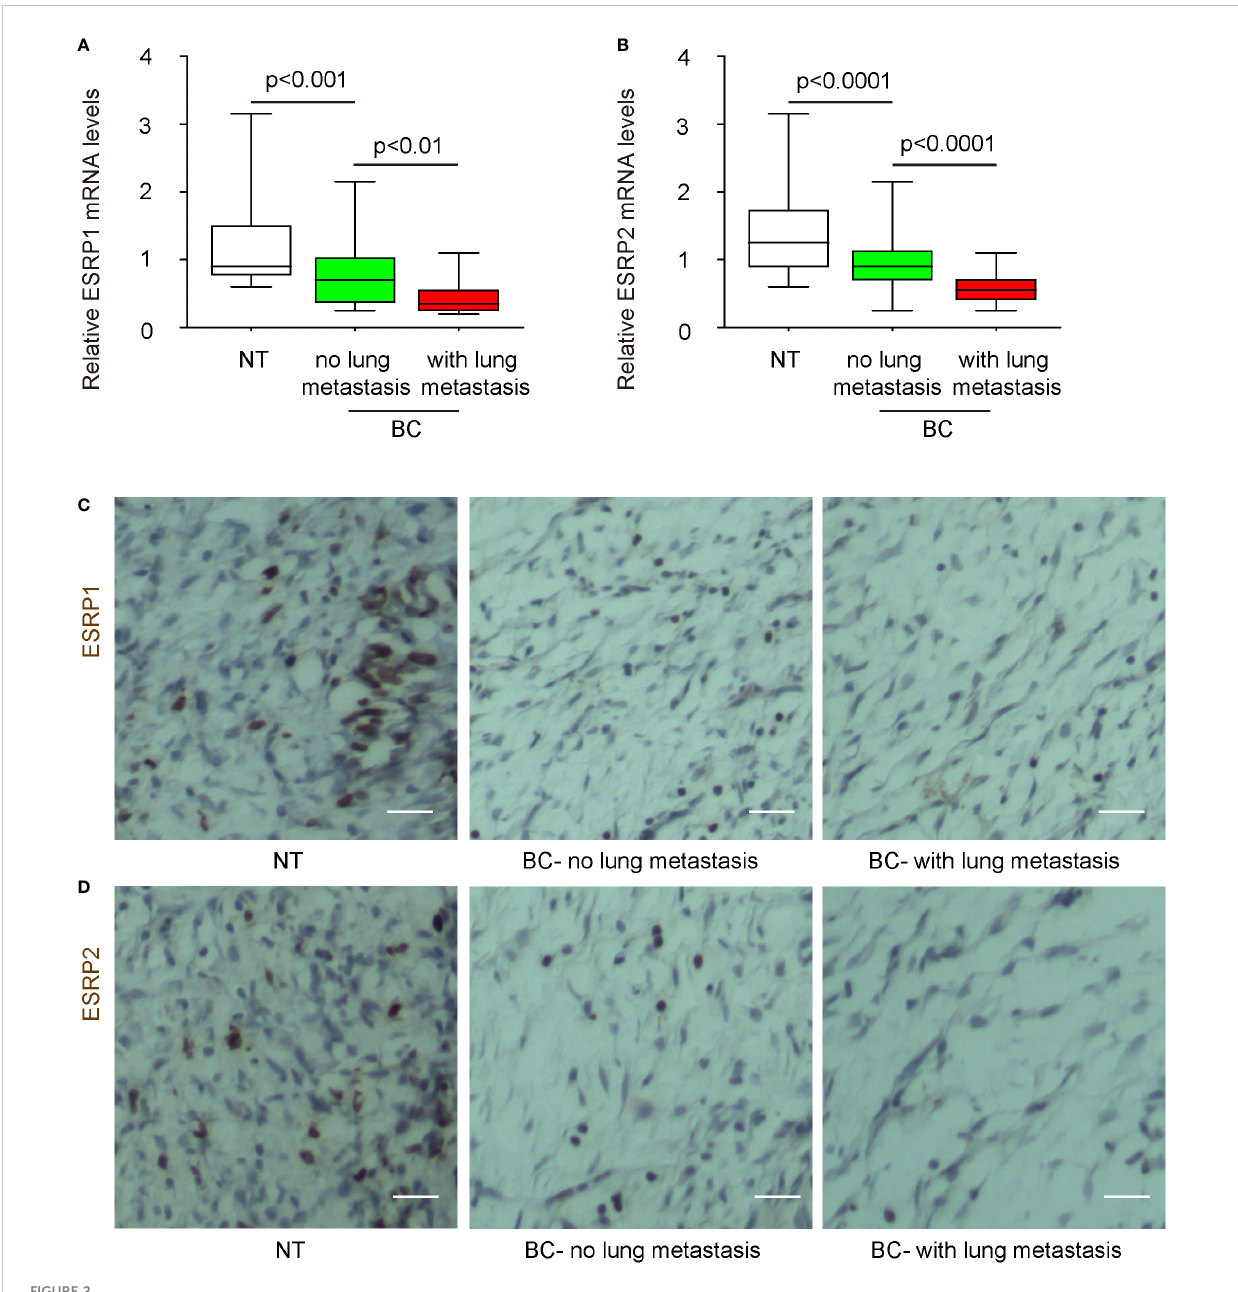
FIGURE 2 BC with lung metastasis express lower mRNA levels of ESRP1 and ESRP2 compared to BC without lung metastasis. The clinic specimens were catalogized into 3 groups: the specimens from NT (N=50), the specimens from BC without lung metastasis (N=40) and the specimens from BC with lung metastasis (N=12). (A, B) RT-qPCR for ESRP1 (A) and ESRP2 (B) in 3 groups. (C, D) Representative immuno fl uorescent images for ESRP1 (C) and ESRP2 (D) in tissue from 3 groups. Scale bars are